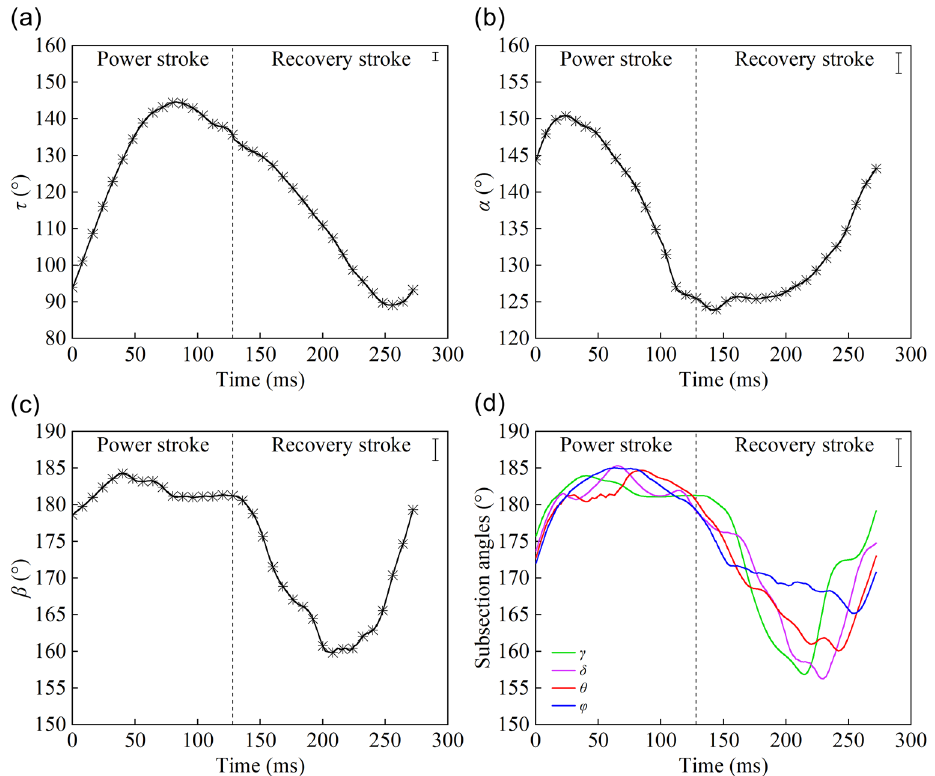
Figure 4. Diagram of the joint angle changes during forward motion: (a) the curve of angle τ ; (b) the curve of angle α ; (c) the curve of angle β ; (d) curves of subsection angles (SIMI Motion 2007, www. simi. com, the carrier of the software is a